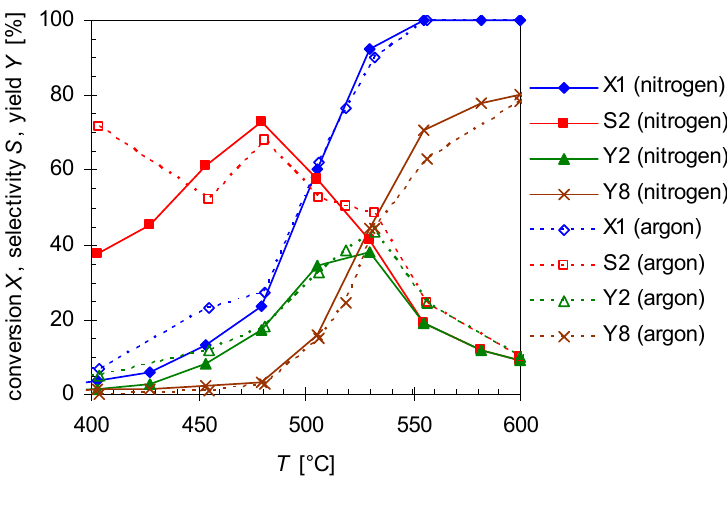
Figure 7. Temperature dependency of pinan-2-ol conversion X (diamonds), linalool 1 (squares), linalool yield Y (triangles), and plinol yield Y (crosses) for the selectivity S 2 2 8 pyrolysis of 1 with nitrogen (solid line) and argon (dotted lines) as carrier gas. Reaction conditions: 30 µL 1 , flow rate: 0.8 L min -1 , τ : 0.6–0.8